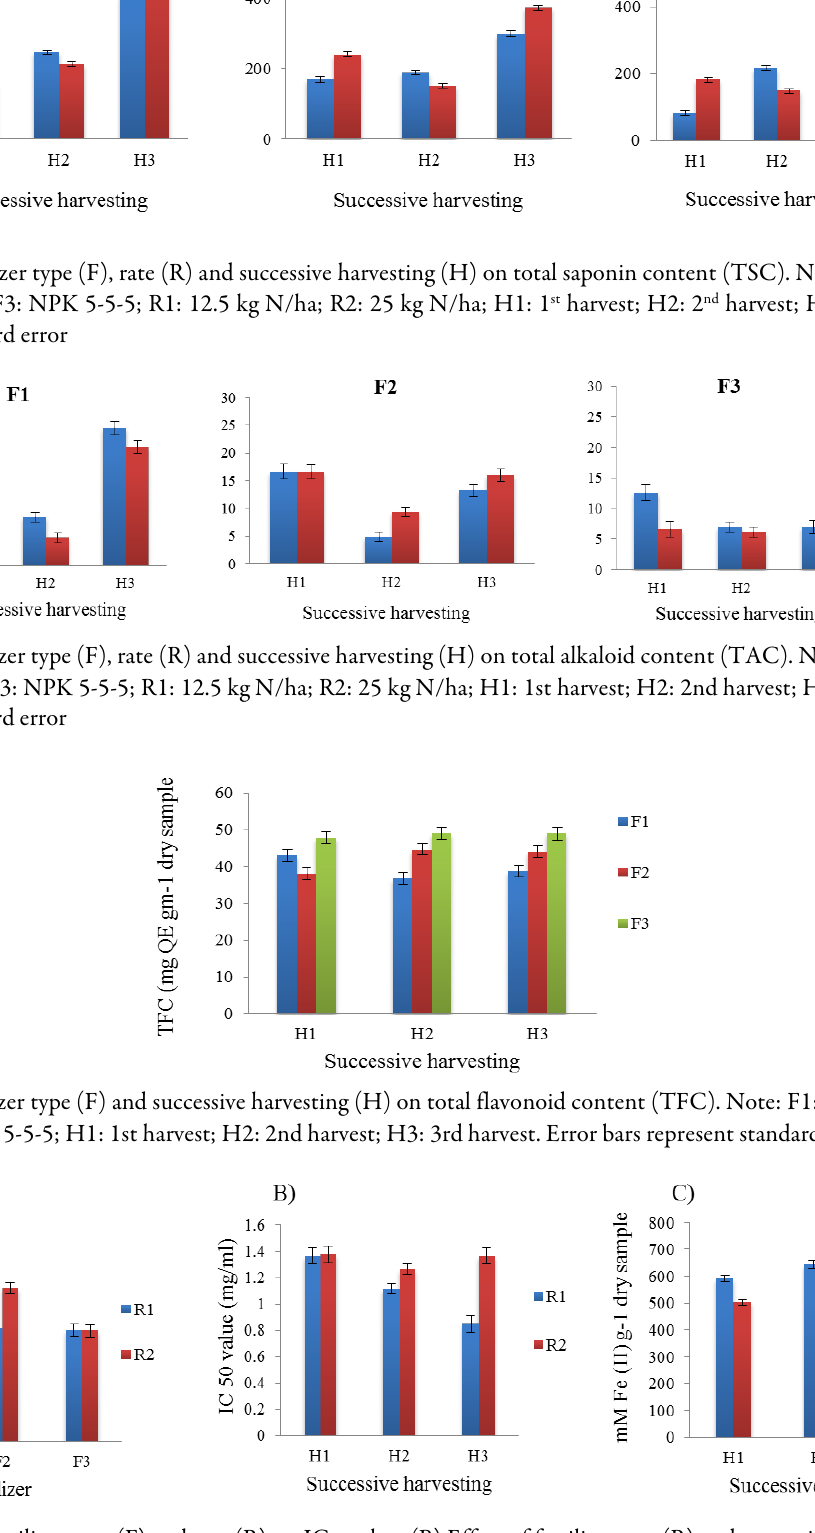
Fig. 5. (A) Effect of fertilizer type (F) and rate (R) on IC IC value; (C) Effect of fertilizer rate (R) and successive harvesting (H) on FRAP value. Note: F1: NPK 15-15-15; F2: NPK 8-8- 50 8; F3: NPK 5-5-5; R1: 12.5 kg N/ha; R2: 25 kg N/ha; H1: 1 st harvest; H2: 2 nd harvest; H3: 3 rd harvest. Error bars represent standard